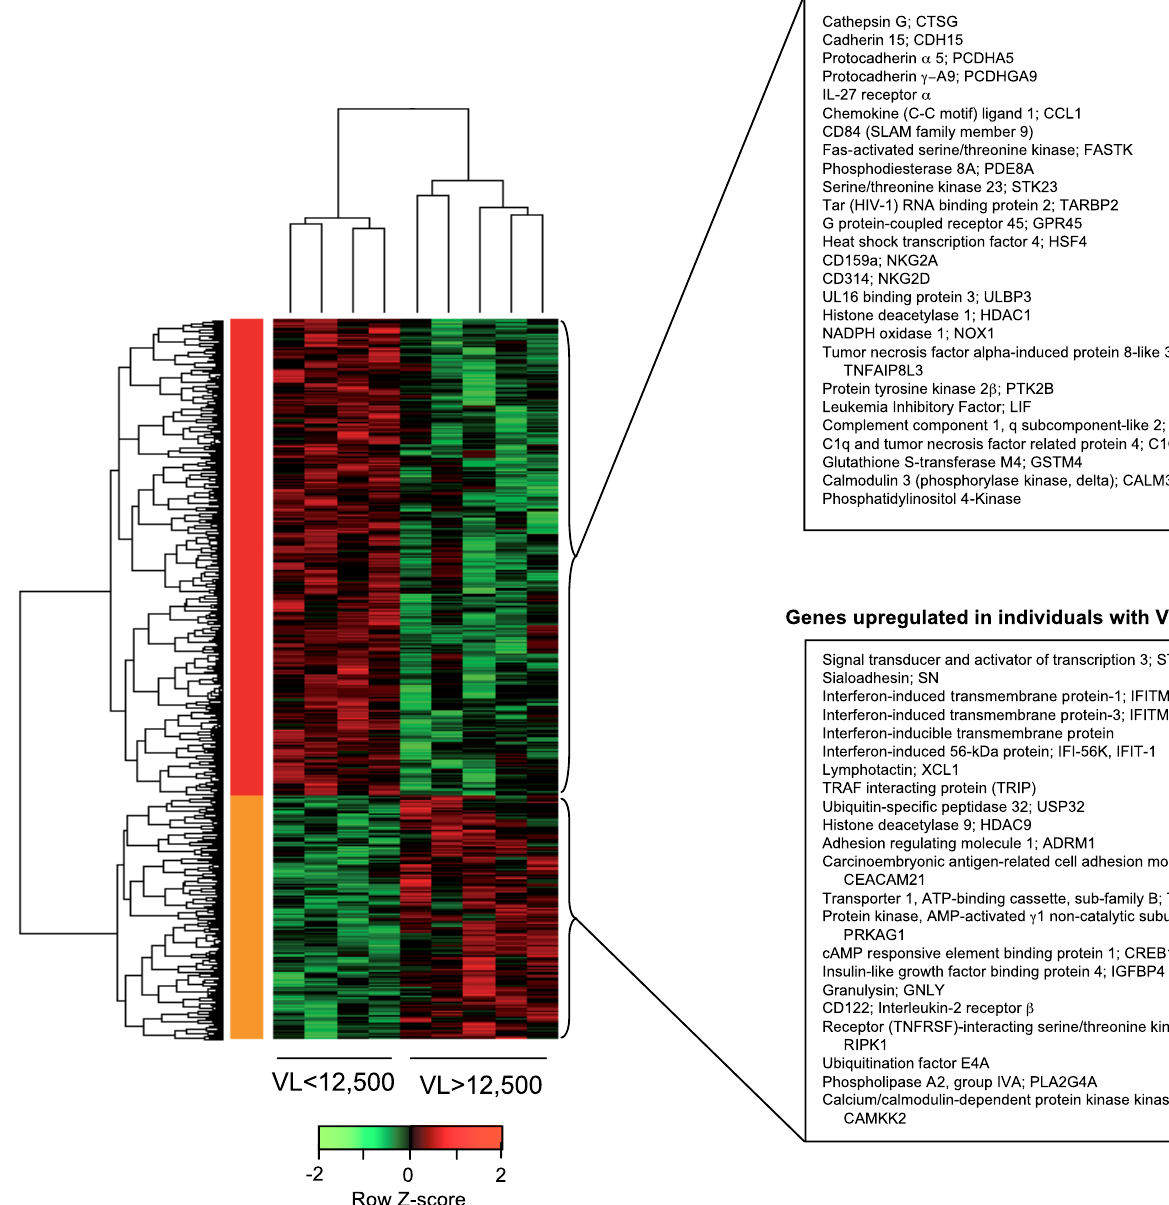
Figure 5. Clustering of differentially expressed genes in unstimulated pDCs from HIV-infected individuals with low versus high viral loads. cRNA was prepared from up to 10 6 pDCs purified from 4 individuals maintaining plasma viremia , 12,500 copies/mL and 5 individuals with uncontrolled viremia . 12,500 copies/ml. Transcriptional profiles were assessed using Applied Biosystems high-density genome survey microarrays. Overall, 596 probes were found to be differentially expressed with p , 0.05, of which examples are listed at right. Variations in relative levels of gene expression (Z- score, scale shown below heatmap) are indicated in color, where red regions indicate upregulation, and green regions indicate downregulation. The hierarchical clustering heatmap was generated using Euclidean distance as the distance measurement between clusters. All genes differentially expressed with p , 0.05 are shown in supplemental Table S1.